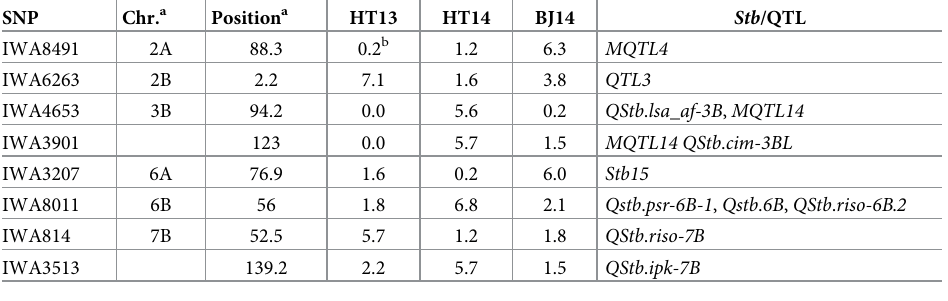
Table 7. Chromosome location and R 2 values of significantly associated SNP markers with Septoriatritici blotch resistance at Holeta (2013 and 2014) and Bekoji (2014), Ethiopia, from the Northwestern elite spring wheat sub- population